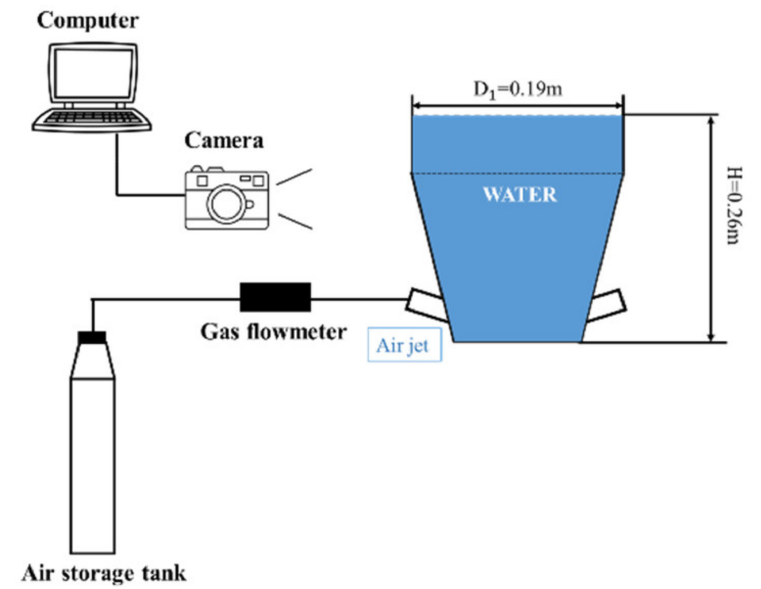
Figure 2. Schematic of experimental